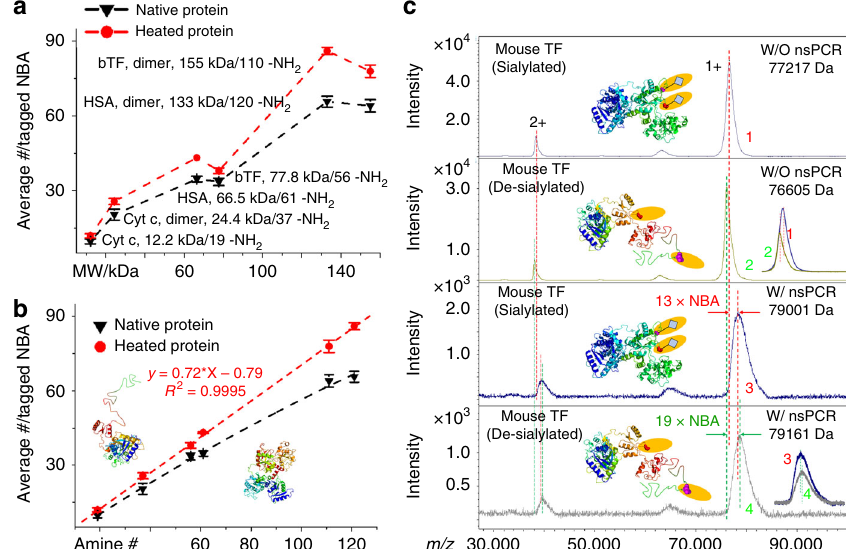
Fig. 4 Large protein labeling via nsPCR. a Correlation between average number of nsPCR-crosslinked NBA and the molecular weight of large proteins. b Correlation between average number of nsPCR-crosslinked NBA and the total number of free amine groups on large proteins. Cyt c, cytochrome c; HSA, human serum albumin; bTF, bovine transferrin. The proteins in control group are preserved with 100 mM ammonium acetate, while unfolded proteins are obtained through heating in 100 mM ammonium acetate at 95 °C for 10 min. The error bars represent S.D. with n = 3 biologically independent experiments. c The structural effects of terminal sialylation on glycoprotein mouse transferrin (TF) probed by nsPCR. As a control (de-sialylated), two sialic acids (Neu5Gc, mass shift between peaks 1 and 2) on mouse transferrin are removed with sialidase under the native condition. The number of surface accessible amine group for sialylated (mass shift between 1 and 3) and de-sialylated (mass shift between peaks 2 and 4) transferrin is probed as 14.4 ± 1.1 ( n = 3) and 20.7 ± 1.3 ( n = 3), respectively. W/O, without; W/, with. Source data is provided in a Source Data fi